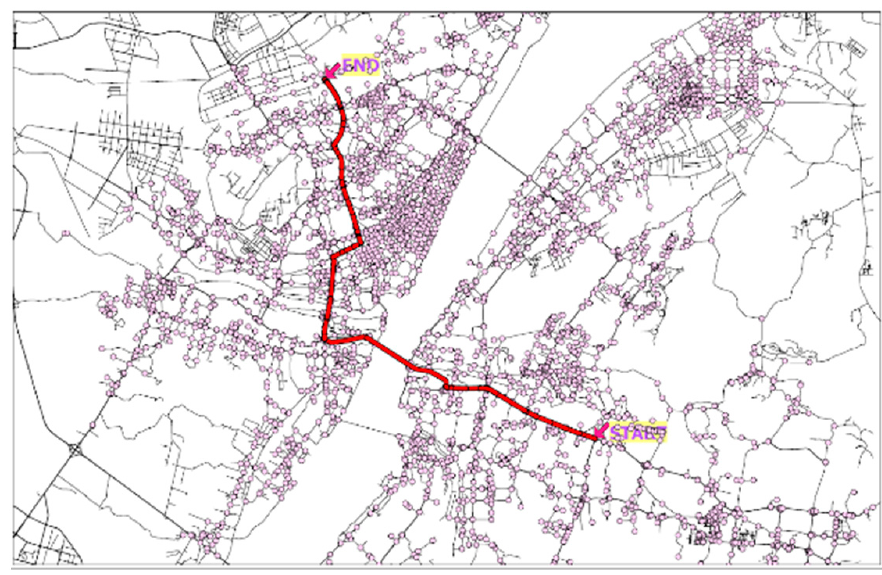
Figure 1. Illustration of Dijkstra’s algorithm [2].